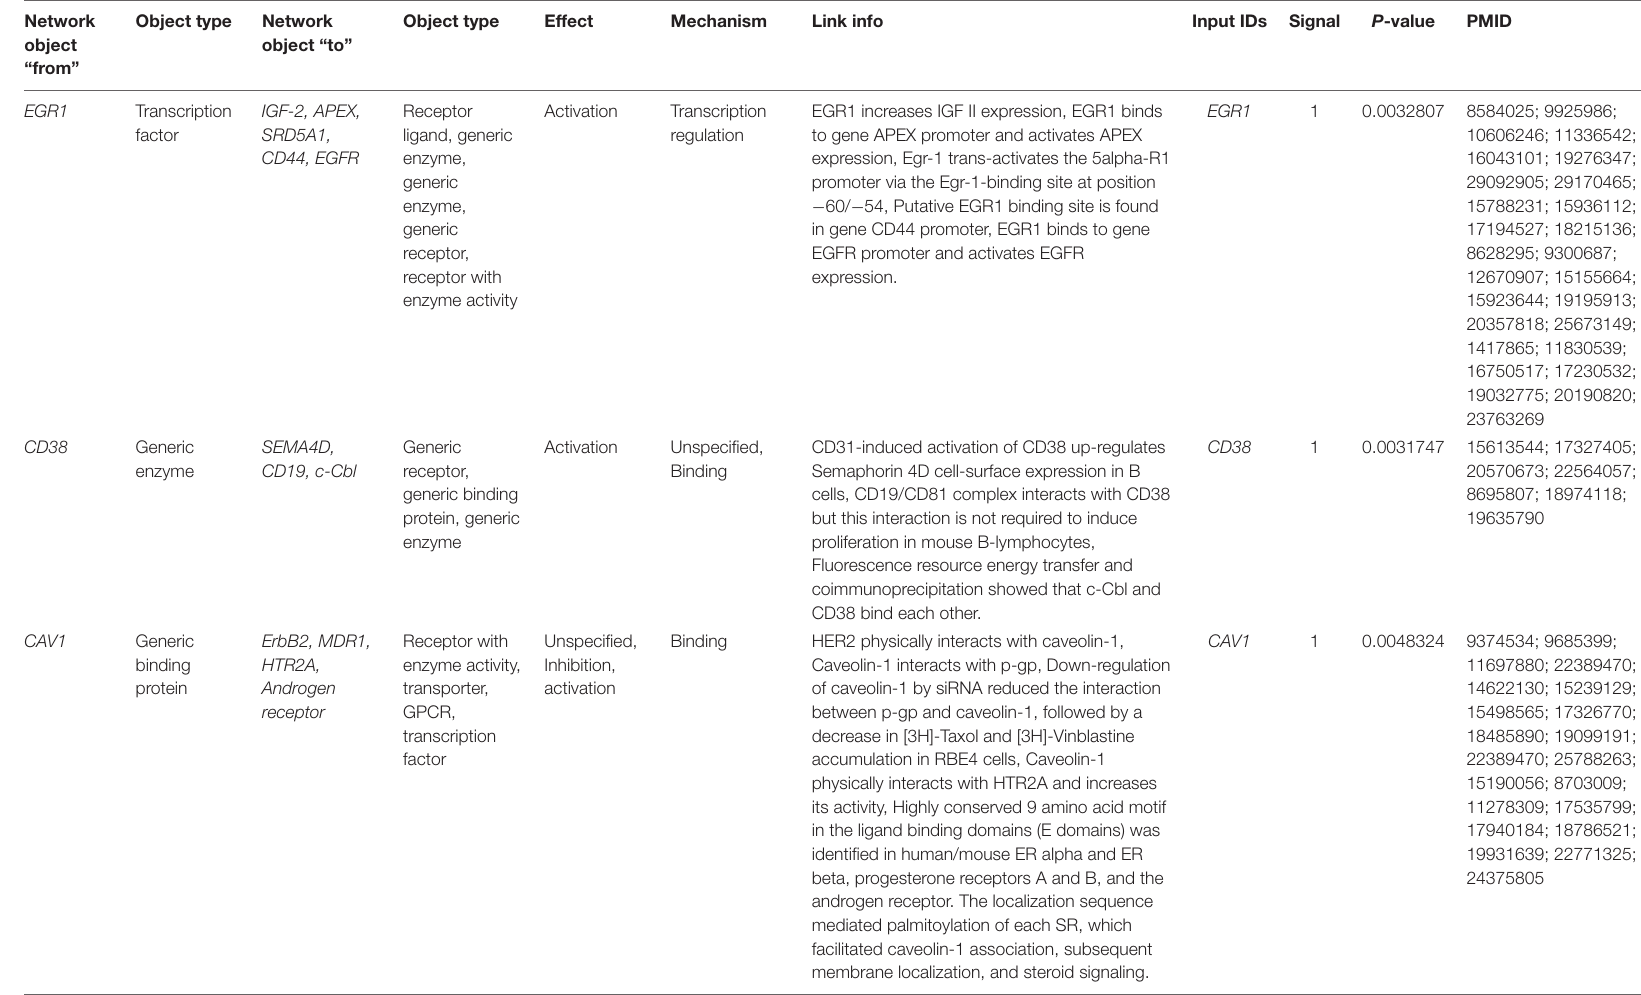
TABLE 4 | The interaction reports of key genes from pathway maps by Clarivate Analytics. Network object